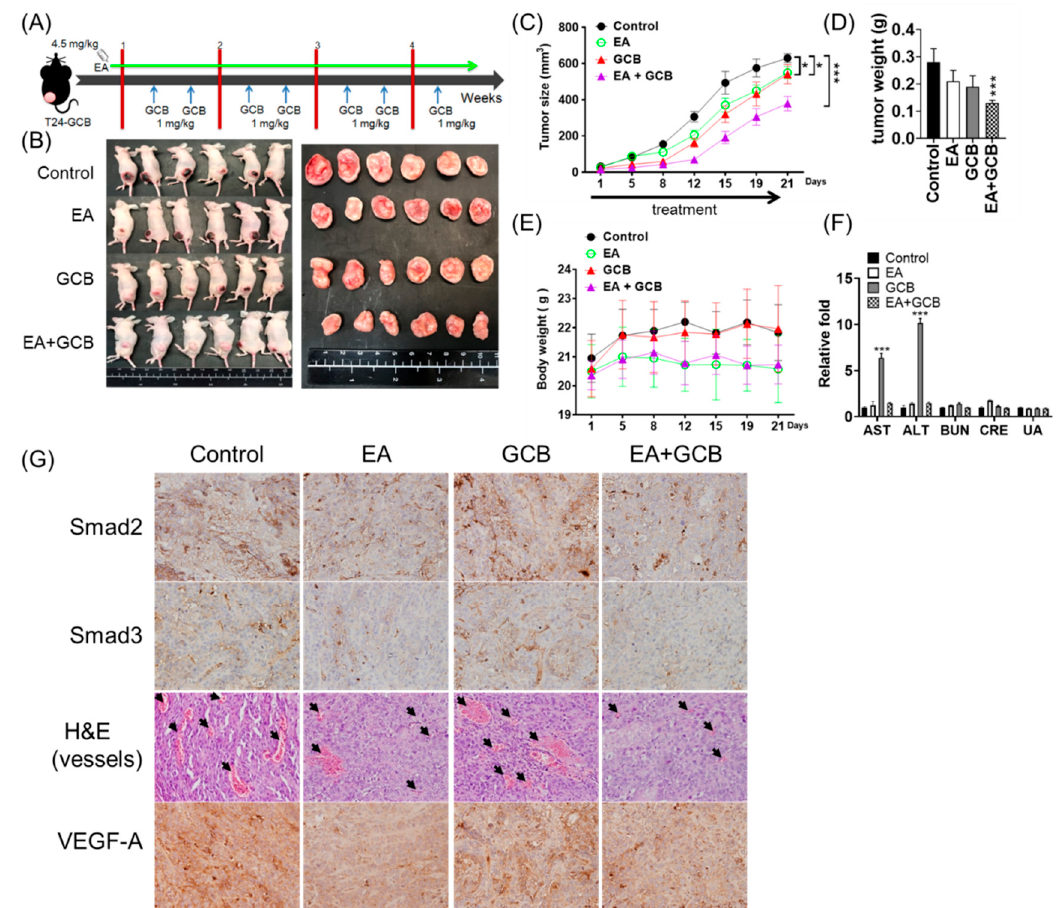
Figure 5. ( A ) Administration procedure of the xenograft and treatment. ( B ) Xenografts of T24-GCB cells were treated with the PBS control, EA (4.5 mg/kg), GCB (1 mg/kg) and EA (4.5 mg/kg) + GCB (1 mg/kg), and in vivo tumors and dissected tumor masses were aligned. ( C ) Curves of tumor size, ( D ) tumor weight, ( E ) mouse body weight and ( F ) liver (AST and ALT) and kidney (BUN, CRE and UA) function among the treated groups. ( G ) Immunohistochemical staining of Smad2, Smad3 and VEGF-A and H&E staining (the black arrows indicate intratumoral vessels) of xenograft tumors among the treated groups. All statistical tests were analyzed with Student’s t test with significance at * < 0.05 and *** < 0.001.